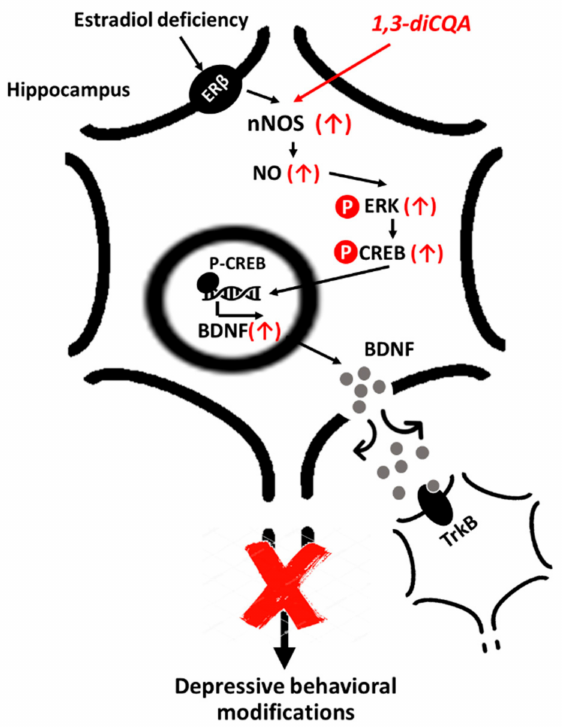
Figure 8. Schematic illustrating the mechanism underlying the effect of 1,3-diCQA in the hippocam- pal neuron. 1,3-diCQA promotes NO production via upregulating nNOS expression without affecting the ERs. 1,3-diCQA may induce changes in depression-like behaviors through the ERK–CREB–BDNF signaling pathway in the hippocampus. Thus, 1,3-diCQA prevents estrogen-deficiency-induced depressive behavioral modifications through the nNOS-NO/ERK–CREB–BDNF signaling pathway network. nNOS; neuronal nitric oxide synthase, NO; nitric oxide, ERK; extracellular-signal-regulated kinases, CREB; cyclic-AMP response-element-binding protein, TrkB: tropomyosin receptor kinase B, ER β ; estrogen receptor beta, 1,3-diCQA; 1, 3-dicaffeoylquinic